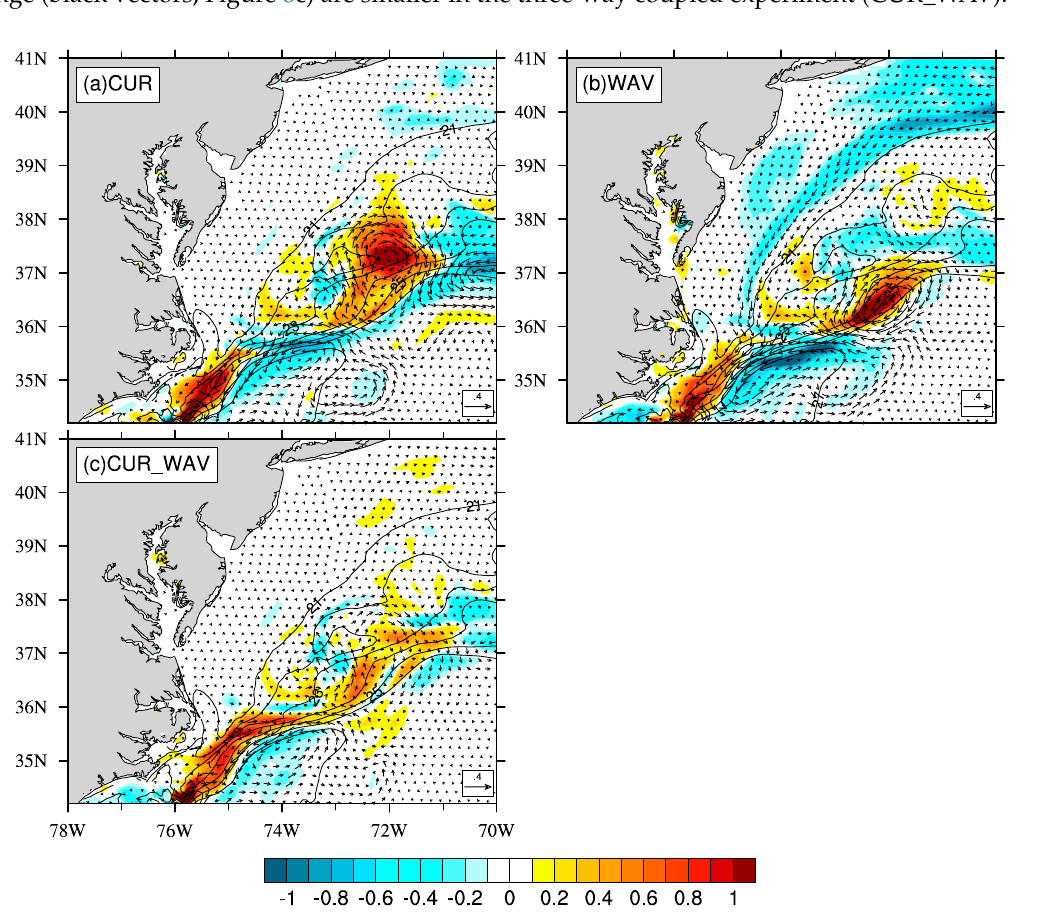
Figure 8. The 30 day averaged SST (shaded, °C) and surface current (vectors, m/s) differences between the ( a ) CUR and CTL, ( b ) WAV and CTL, ( c ) CUR_WAV, and CTL experiments. The monthly-averaged SST from the CTL experiment is also plotted as black contours (CI = 1 °C).